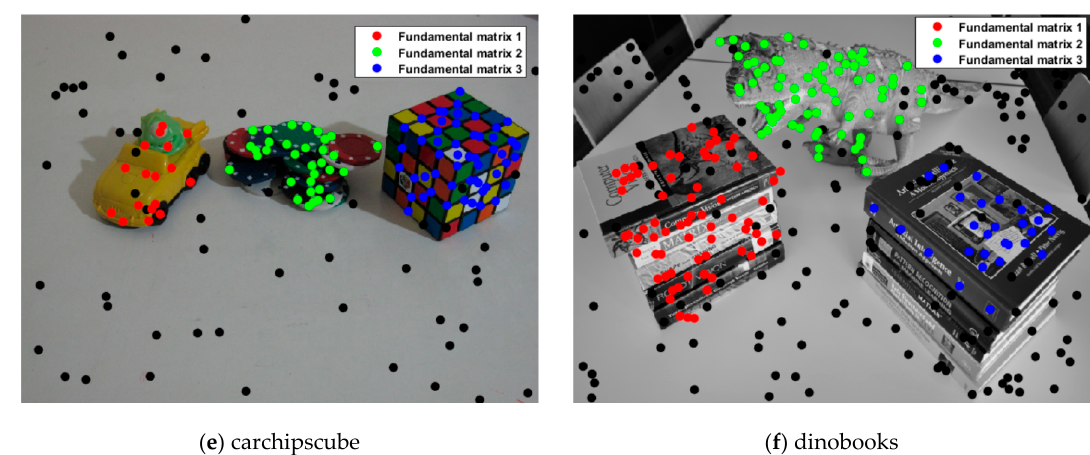
Figure 8. Inlier segmentation results for the multi-fundamental matrix estimation.